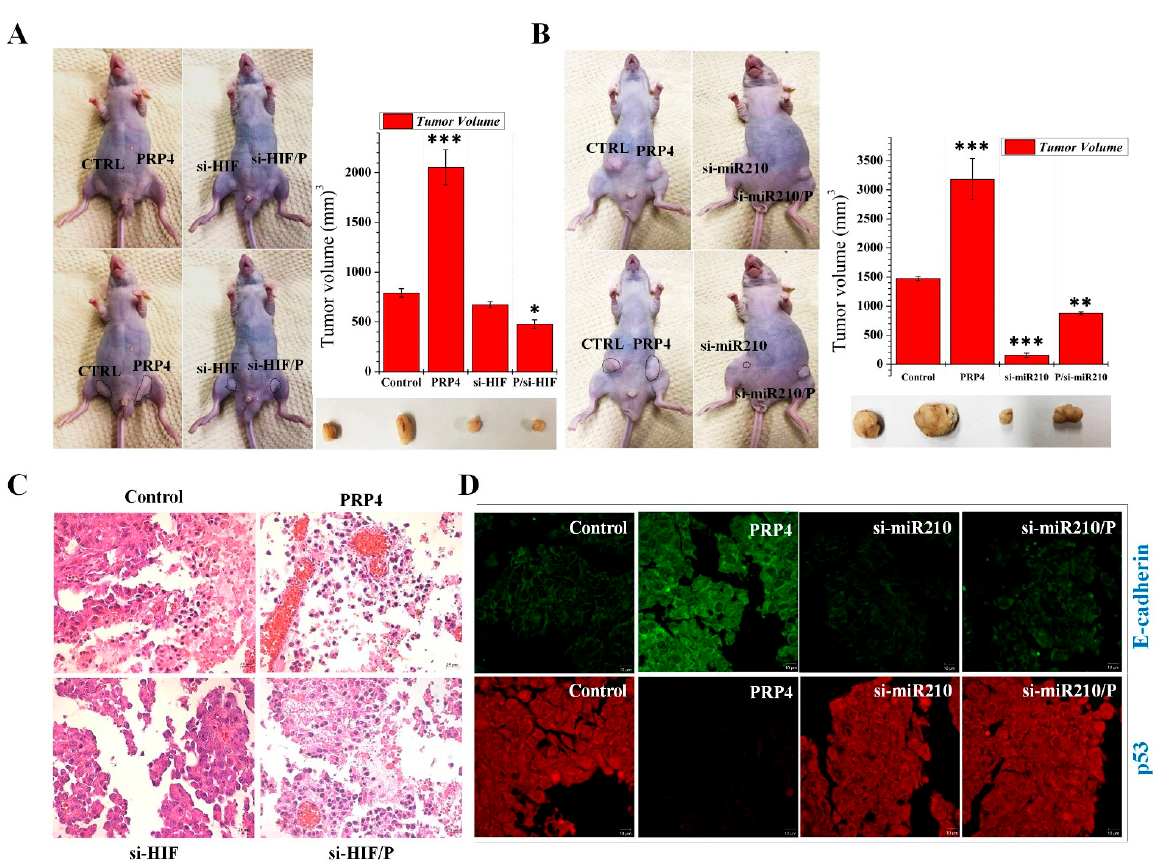
Figure 7. PRP4-induced tumors are associated with the upregulation of HIF-1 α and miR-210 in vivo: ( A , B ) Representative images of xenotransplant tumors in nude mice. The first group were implanted with parental HCT116 cells (control, on the left as per the photograph) and PRP4-overexpressed HCT116 cells on the right. The second group received silenced (si-HIF/si-miR210)-transfected HCT116 cells on the left and PRP4-overexpresed and silenced (si-HIF/si-miR210-transfected) cells on the right. Tumor sizes were measured at 3- or 4-day intervals until 50 days after postimplantation of cells. For clear visibility of the tumors in vivo, the same mouse was photographed twice, and the tumors are encircled in the second photograph. Data shown are from three independent experi- ments. * p < 0.05, ** p < 0.01, *** p < 0.001; ( C ) sections of the xenotransplant tumors isolated from each of the four conditions were subjected to Hematoxylin and Eosin (H&E) staining. Cell staining includes light pink cytoplasm, red erythrocytes, pink collagen, blue nuclei, and pink/rose muscle tissue. The tumors subjected to HIF-1 α silencing contained fewer erythrocytes than their counter- part PRP4-overexpressing tumors; ( D ) immunofluorescence microscopy of mouse tumor sections immunostained with anti-p53 and anti-E-cadherin antibodies.